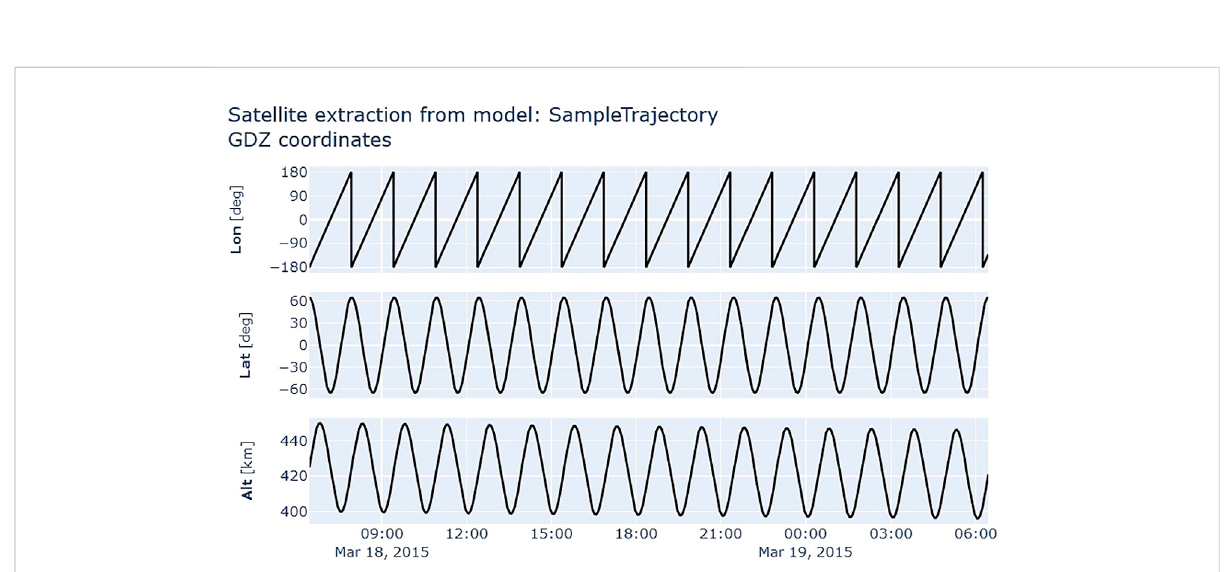
FIGURE 3 The default trajectory produced by the SampleTrajectory function. Together, the plots show the position of the imaginary satellite in geodetic spherical coordinates(longitude, latitude, and altitude) for a 24-h period. Note thelongitude begins at-180 but ends slightly above that value dueto the precession in longitude, which can be chosen by the user. The default latitude range is centered on the equator as shown, but any continuous rangecanbechosen.Bydefault,thealtitudevariesineachorbitanddegradesslowlyovertime.Therateofdegradationcanalsobeadjusted via an input parameter. See documentation for more details 9